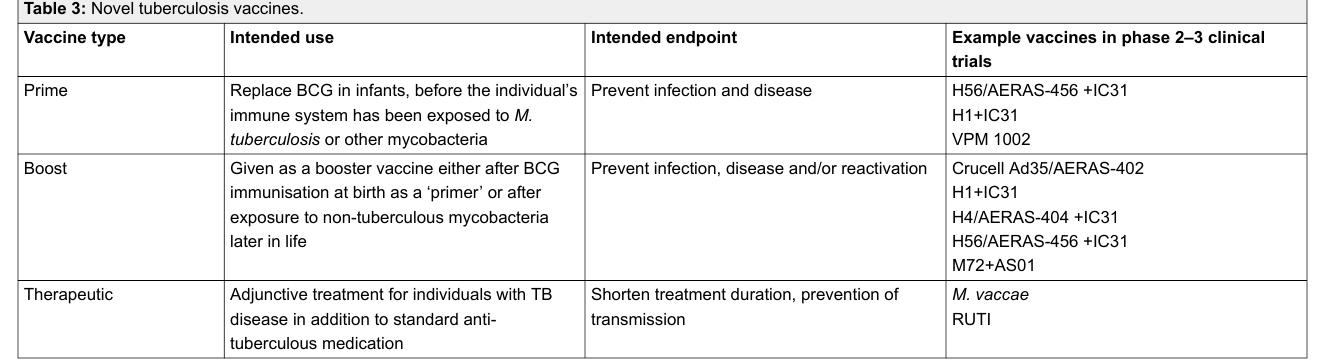
Table 3: Novel tuberculosis vaccines. Vaccine